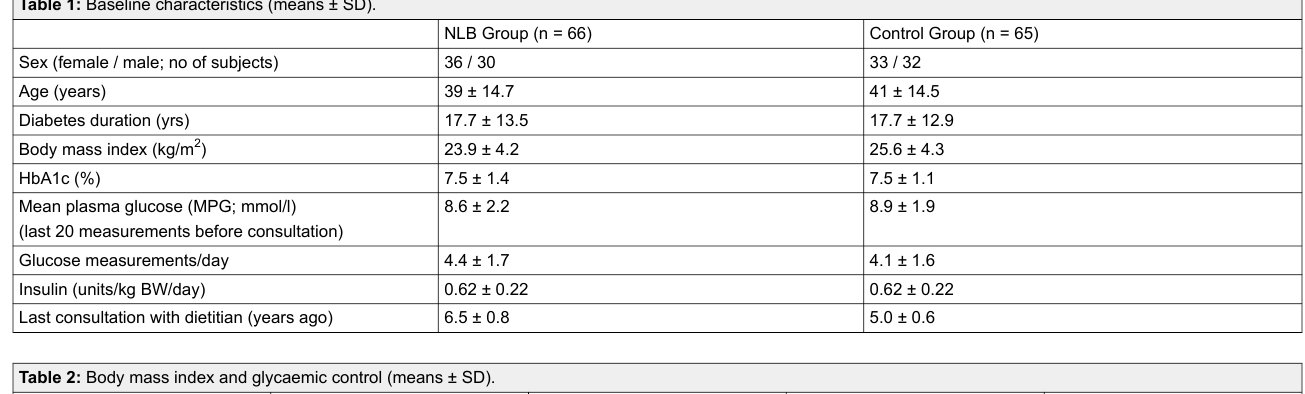
Table 2: Body mass index and glycaemic control (means ± SD).